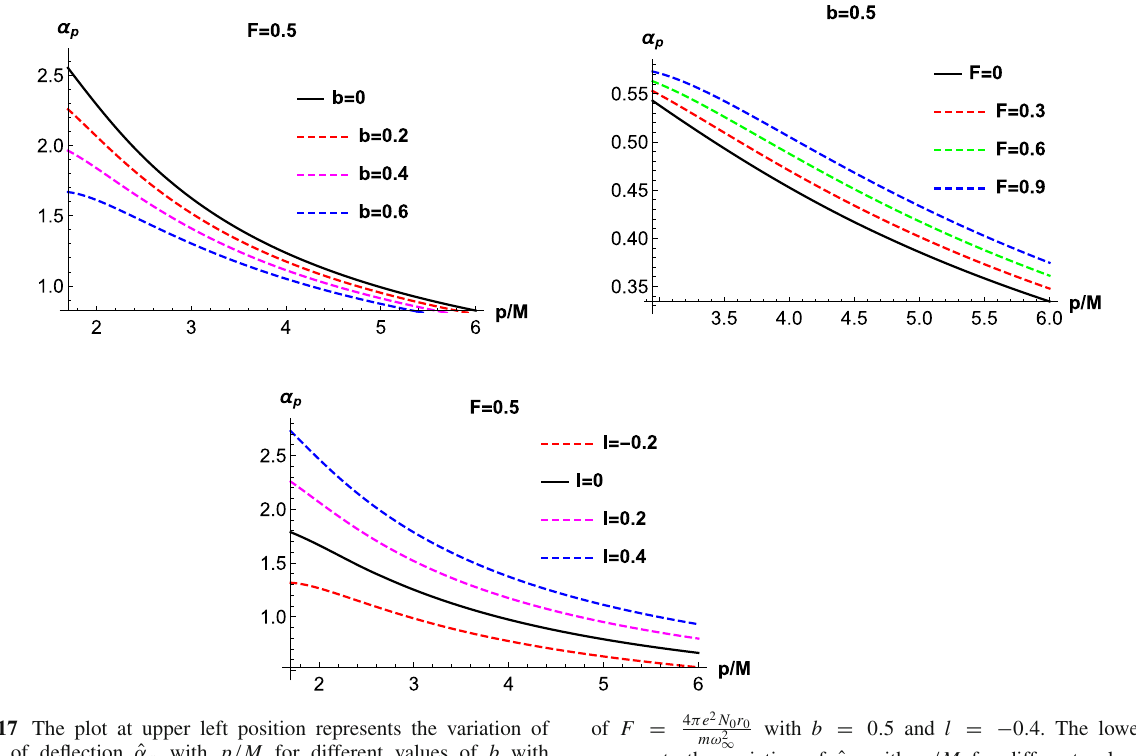
with b = 0 . 5 and l = − 0 . 4. The lower one of F = 4 π e 2 N 0 r 0 m ω 2 ∞ represents the variation of ˆ α p with p / M for different values of l = 0 . 5 and b = 0 . with F = 4 π e 2 N 0 r 0 m ω 2 ∞